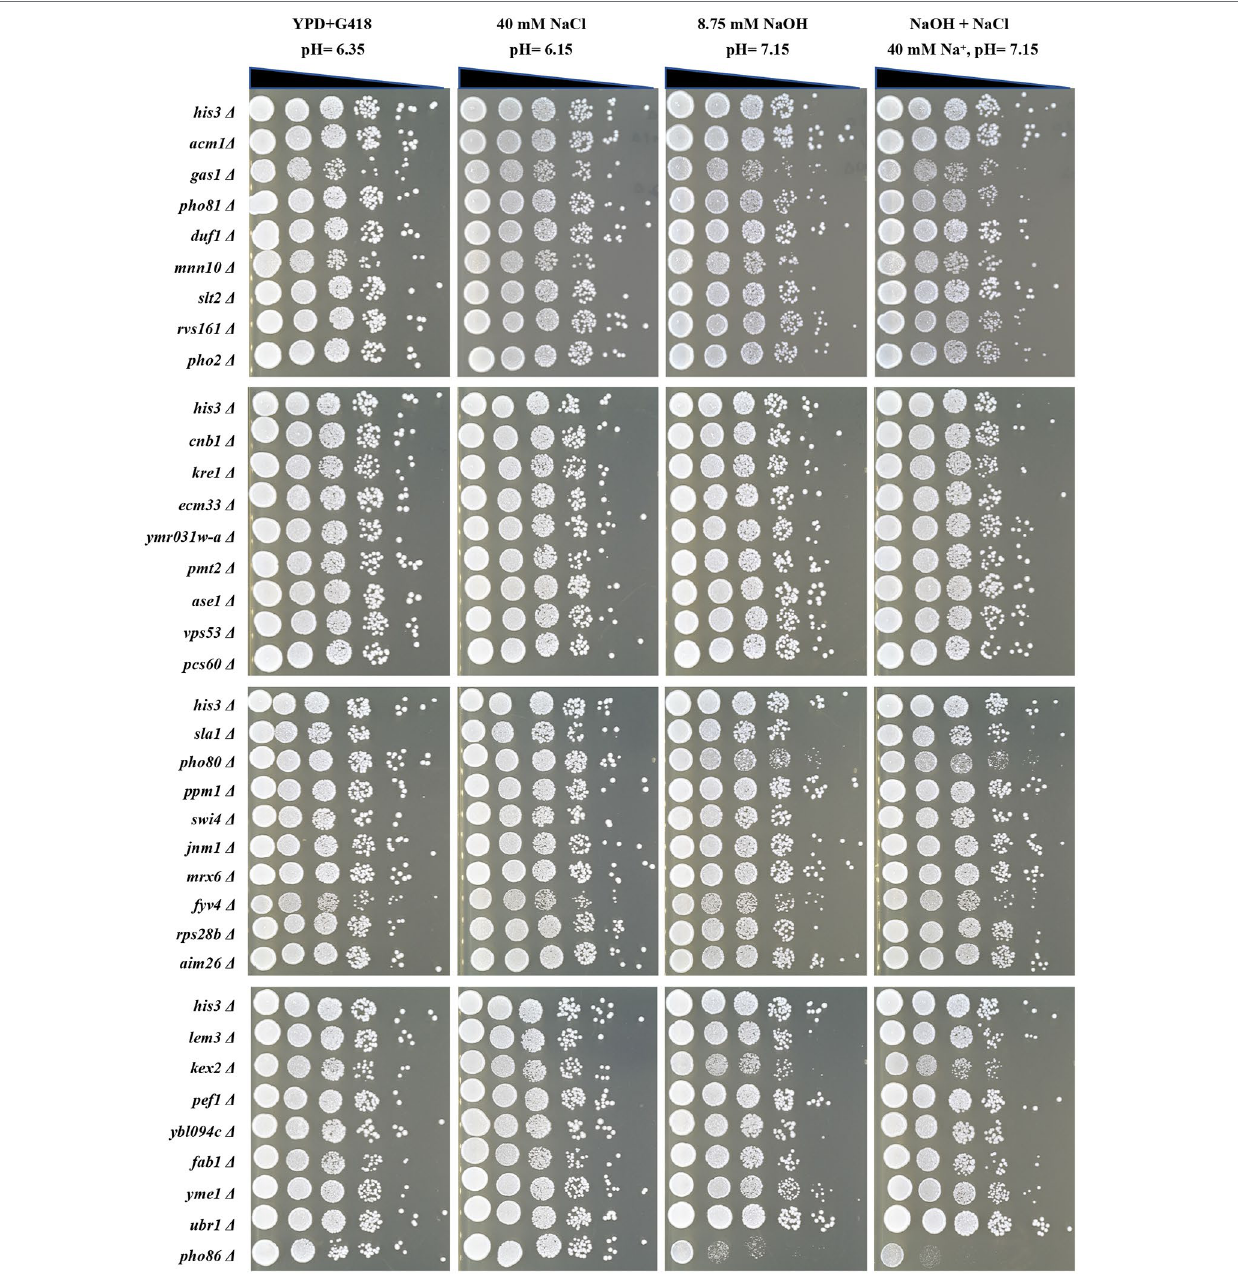
FIGURE 4 | Spot test of the 33 selected deletion mutants under stresses with the same pH and Na + concentration as 40 mM NaHCO 3 . The control strain and deletion mutants were grown to mid-log phase in YPD + G418 liquid medium and then diluted to an OD 600 = 0.5. Each strain was serially diluted in a 10-fold gradient and 5 μ l were spotted onto differently treated agar plates. The pH = 7.15 plates were adjusted with NaOH. Plates were incubated at 30 ° C and photographed after 48